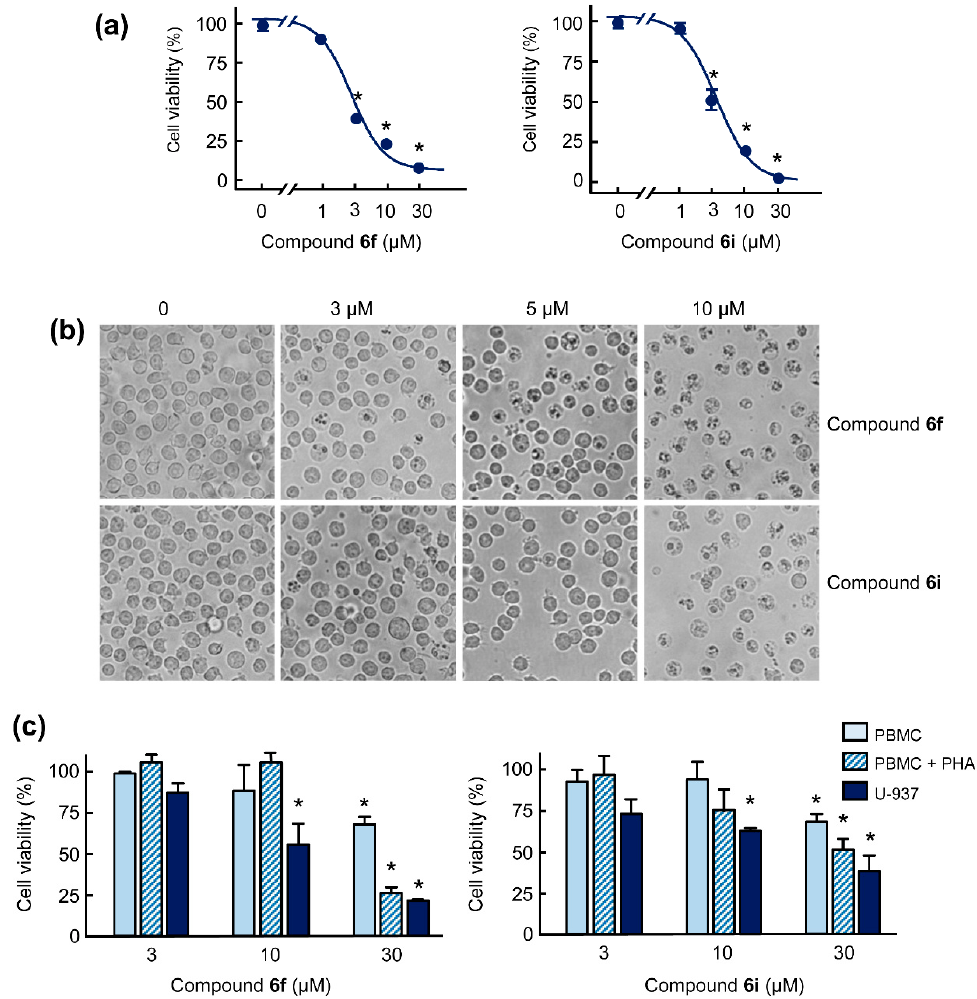
Figure 2. ( a ) Dose-response study of hybrid chalcone–guanidines on human U-937 leukemia cell viability. Cells were cultured in the presence of increasing concentrations of selected guanidines for 72 h, and thereafter cell viability was determined by the MTT assay. ( b ) Photomicrographs of morphological changes visualized with an inverted phase-contrast microscope after treatment of U-937 cells with the specified guanidine for 24 h. ( c ) Differential effects of guanidines on cell viability of normal peripheral blood mononuclear cells (PBMC) versus U-937 cells. Human leukemia and quiescent and phytohemagglutinin-activated PBMC (PBMC (+PHA)) cells from healthy human origin were cultured in the presence of the specified concentrations of guanidines for 24 h. Values represent means ± SE of three independent experiments each performed in triplicate. * p < 0.05, significantly different from the corresponding